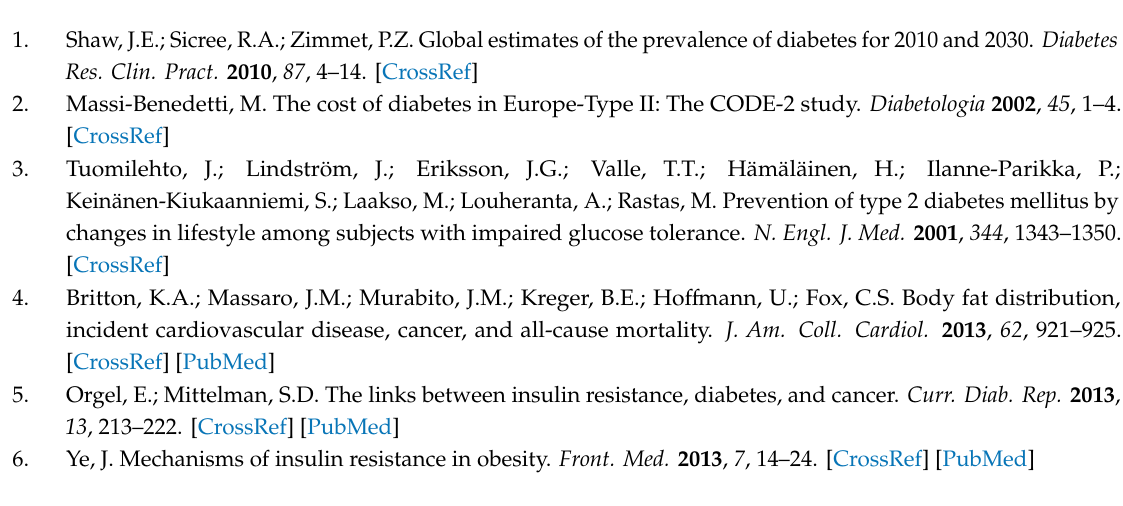
Figure S1: Association between ABSI, BMI and HbA1c; Model adjusted for age and gender. ABSI and BMI were mutually adjusted. Table S1: Sample characteristics by